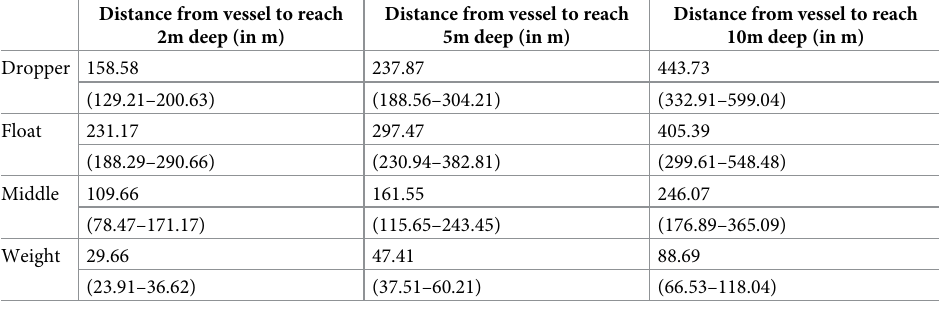
Bayesian 95% CRI are also displayed in brackets. For more detailed tables see Supporting